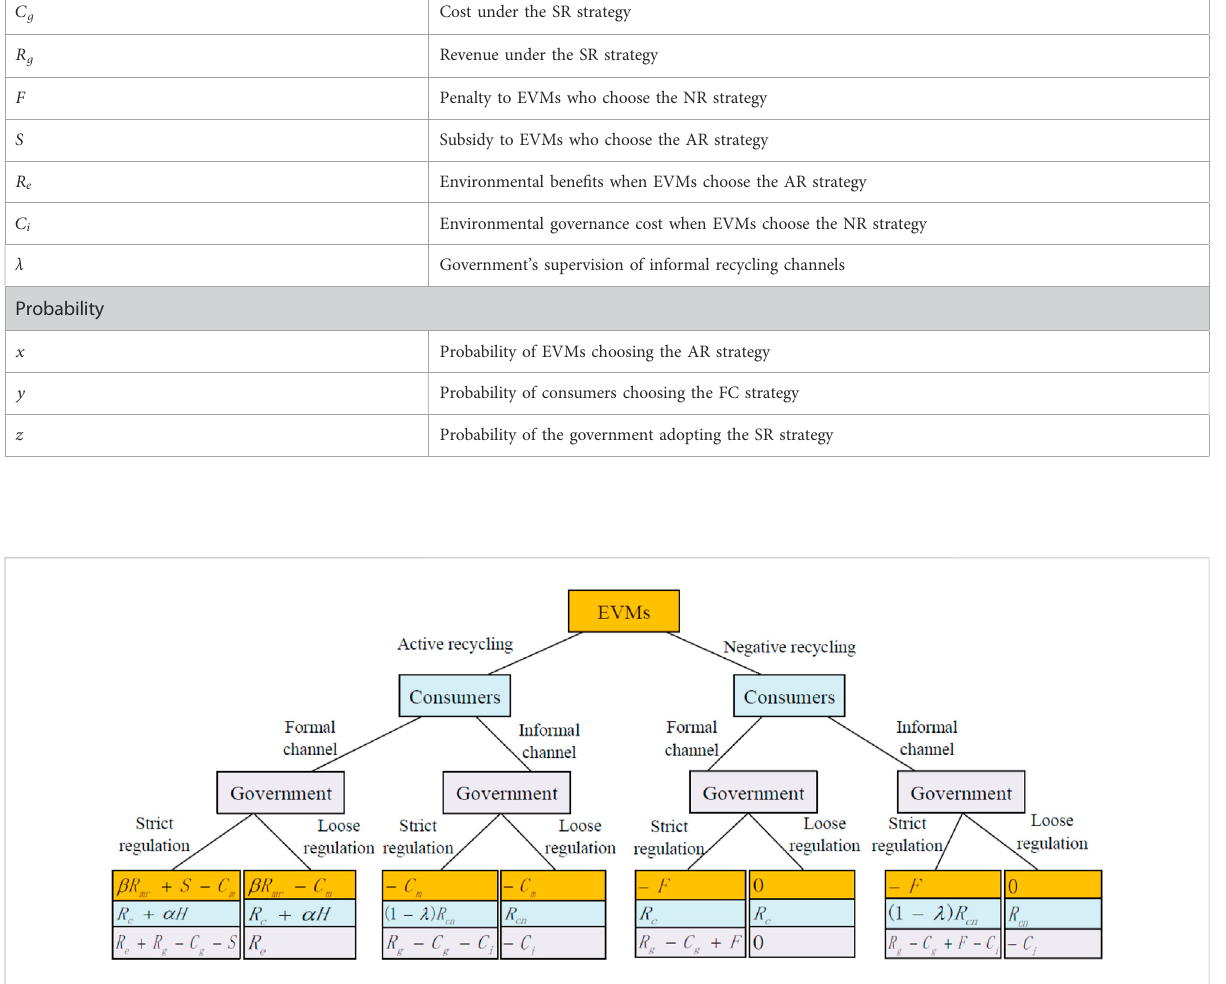
FIGURE 2 Game tree of the three